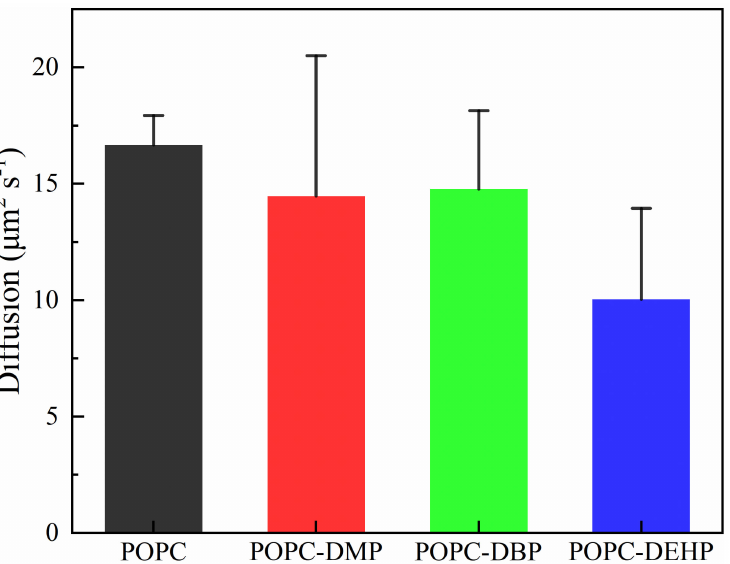
Figure 6. The effects of different PAEs on the lateral diffusion coefficient of POPC